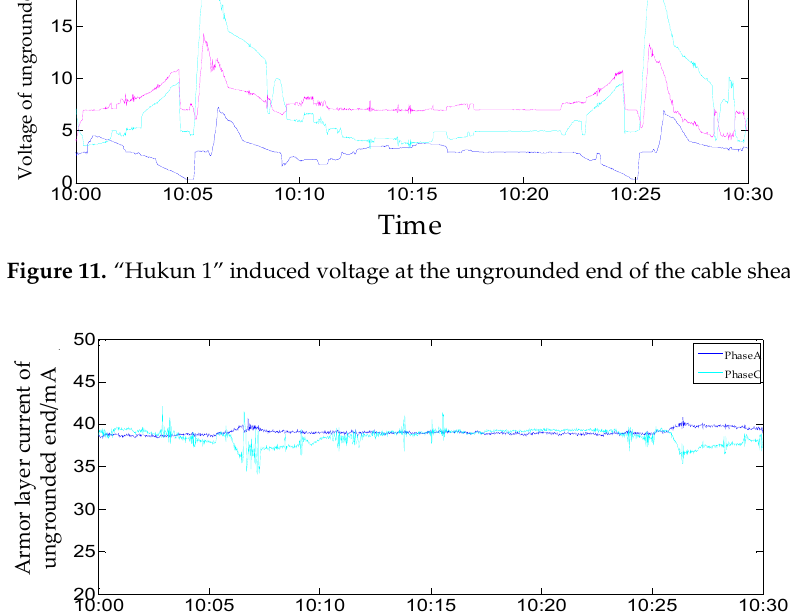
Figure 12. “Hukun 1” circulating current of cable sheath at the ungrounded end.